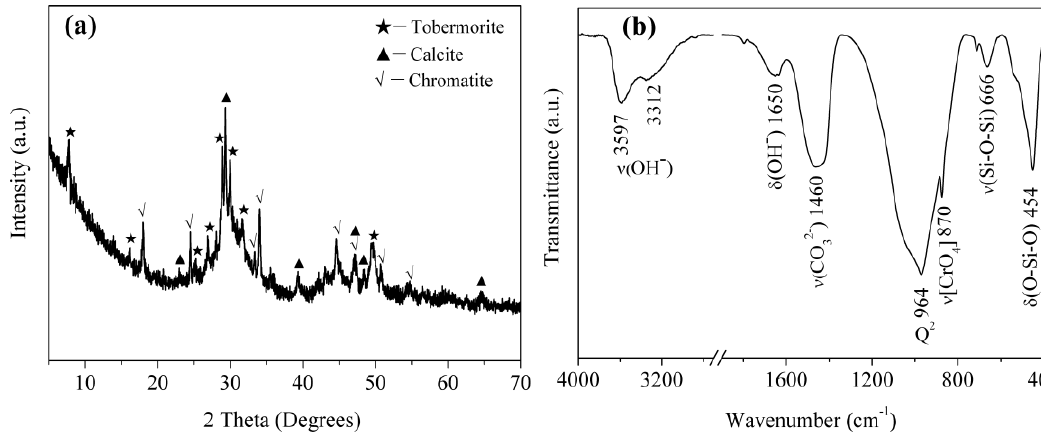
Figure 13. XRD pattern ( a ); and FT-IR spectra ( b ) of the tobermorite reacted with Cr(VI).